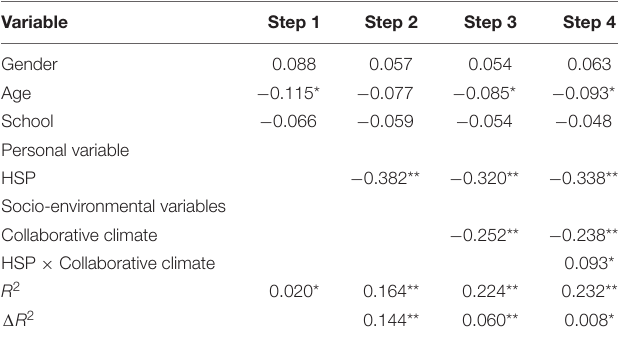
FIGURE 1 | Interaction effect of Japanese schoolteachers’ help-seeking preference and their collective perceptions of collegial organizational climate (dependent variable: burnout